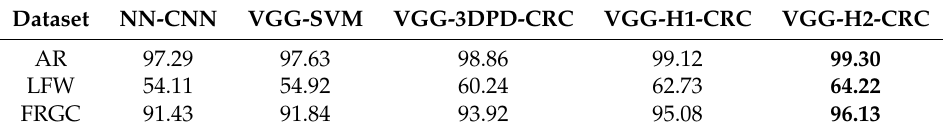
Table 7. Face recognition rates (%) of deep learning-based approaches on different